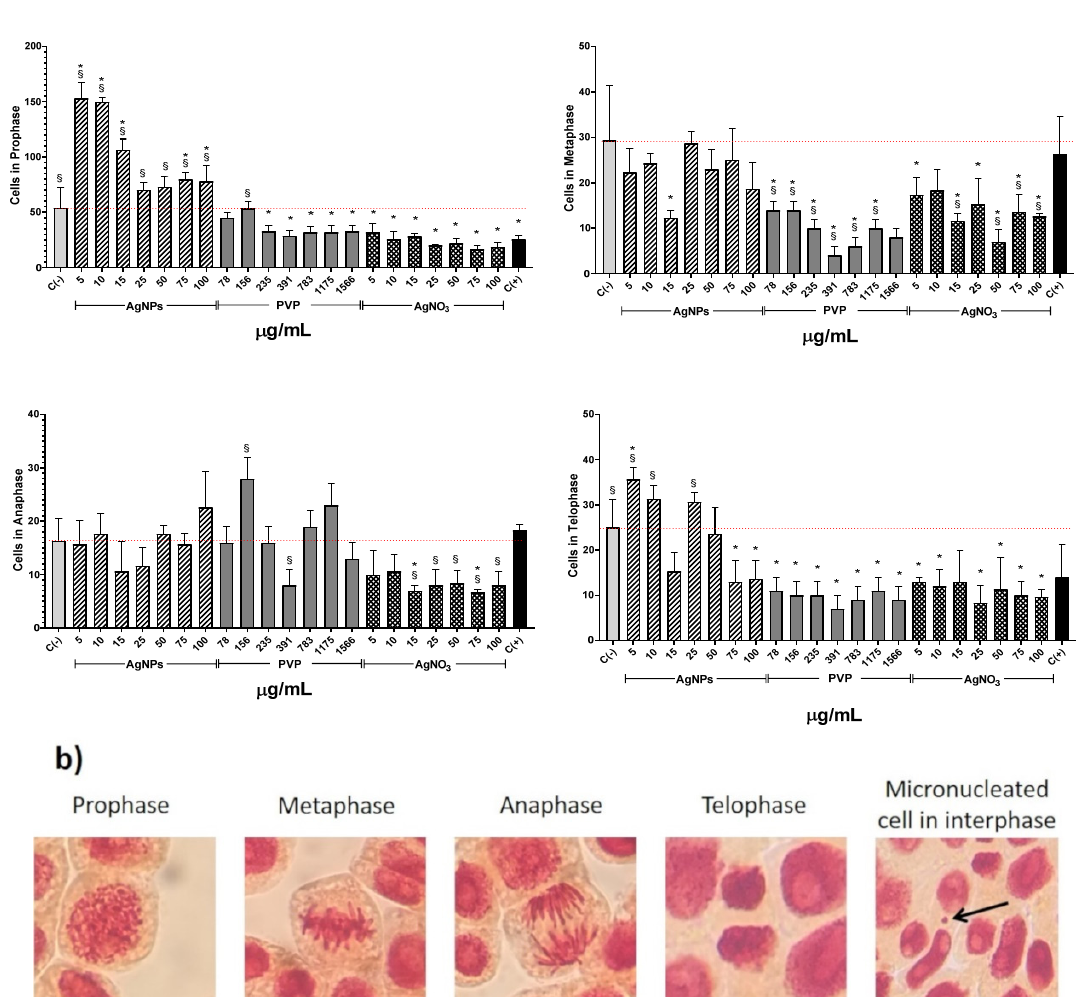
Figure 4. E ff ects elicited by AgNPs, PVP, and AgNO 3 on mitosis of Allium cepa root cells. ( a ) Cell population in each phase of mitosis after 72 h of exposure to several concentrations of AgNPs (lined), PVP (dark gray), and AgNO 3 (grid). C- corresponds to untreated plants (light gray) and C + to those exposed to 0.37 µ g / mL of sodium arsenite (black). * Indicates significative di ff erences with the negative control (p < 0.05); § indicates significative di ff erences with the positive control ( p < 0.05). ( b ) Representative photographs of cells at di ff erent stages of mitosis. Images were obtained with a digital camera adapted to the microscope using a 40 × objective.